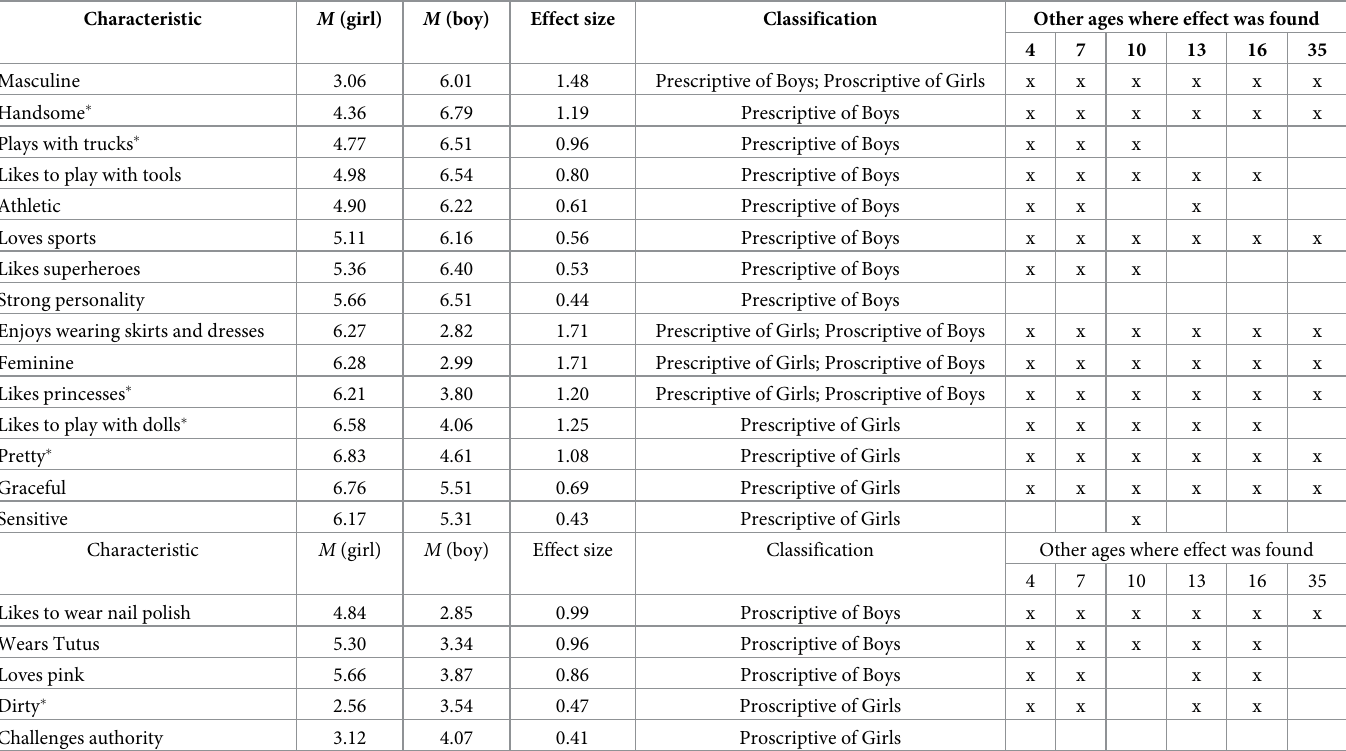
Table 9. Characteristics that were rated as prescriptive/proscriptive of one-year-old children. Characteristic M (girl)